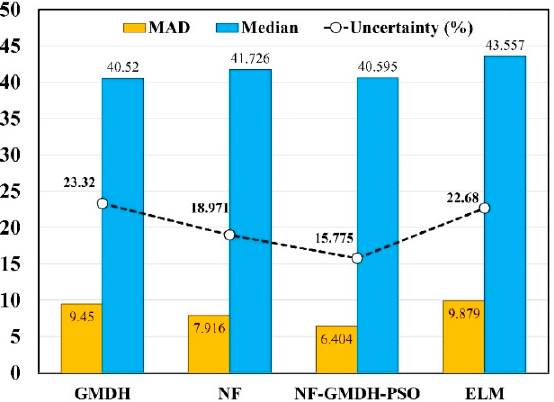
Figure 11. AI models uncertainty analysis using Monte Carlo simulations.